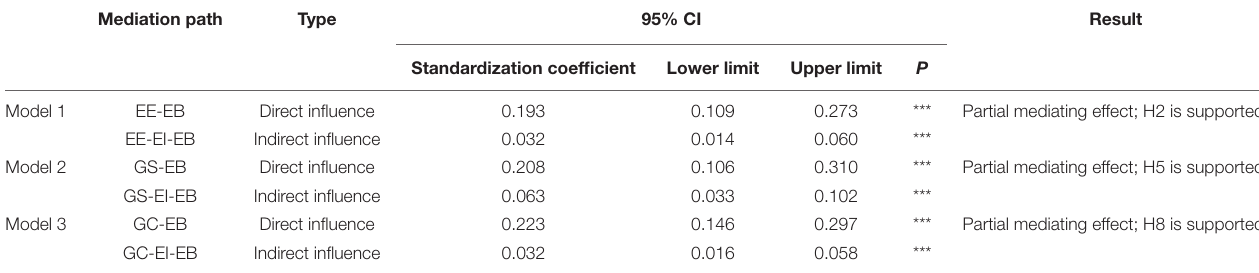
TABLE 4 | Influence test with entrepreneurial intention as single mediator.